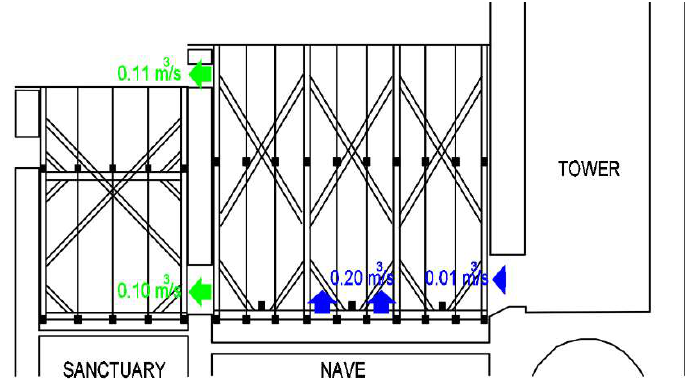
Figure 20. Airflow paths at 6:00 a.m. obtained from BPS simulation in section.